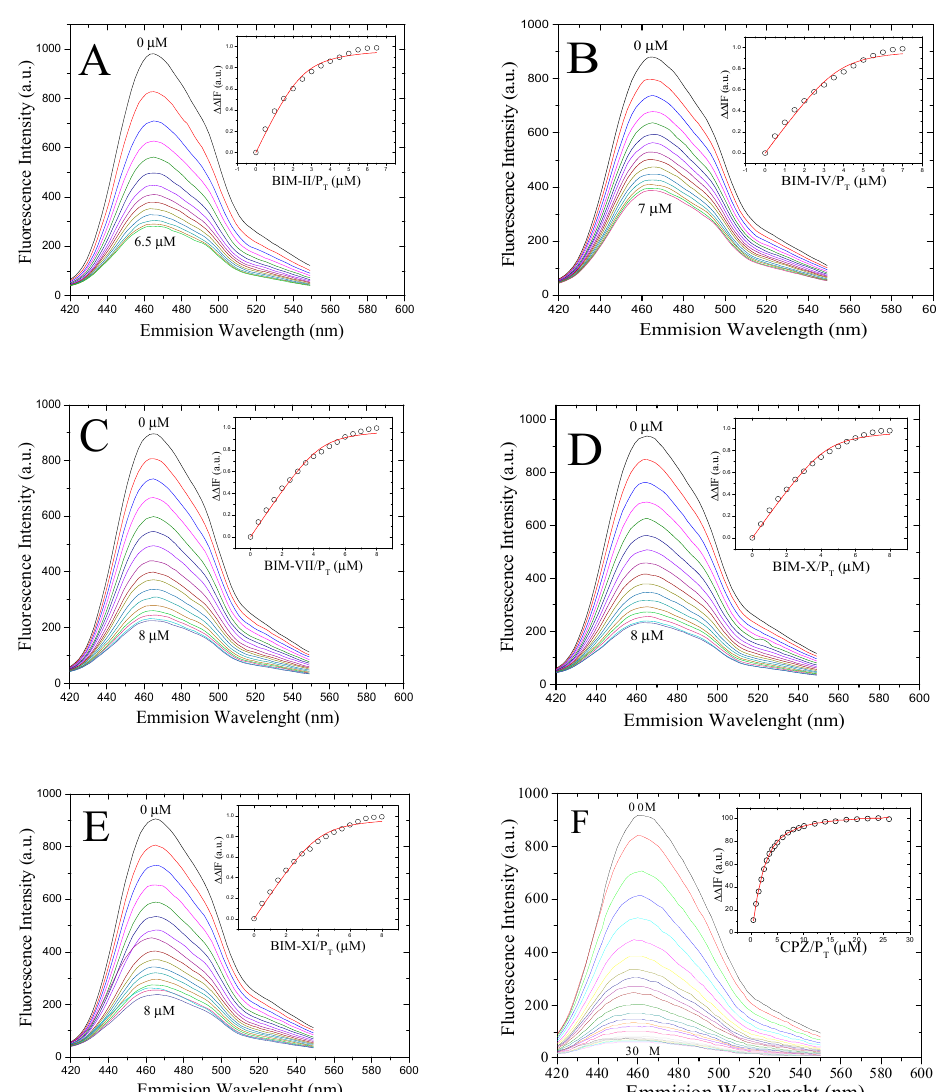
Figure 3. Fluorescence spectra and titration curves of Ca +2 - h CaM M124C- mBBr with BIM-II ( A ), BIM-IV ( B ), BIM-VII ( C ), BIM-X ( D ), BIM-XI ( E ), and CPZ ( F ). Buffer was 10 mM of potassium acetate pH 5.1 at 37 °C. The absolute changes of maximal fluorescence emission were corrected for light scattering effects and plotted against the ligands to total protein ratio (insets). The continuous line in the insets comes from data fitting to the binding model (Equation (1) in the experimental section) to obtain the K d